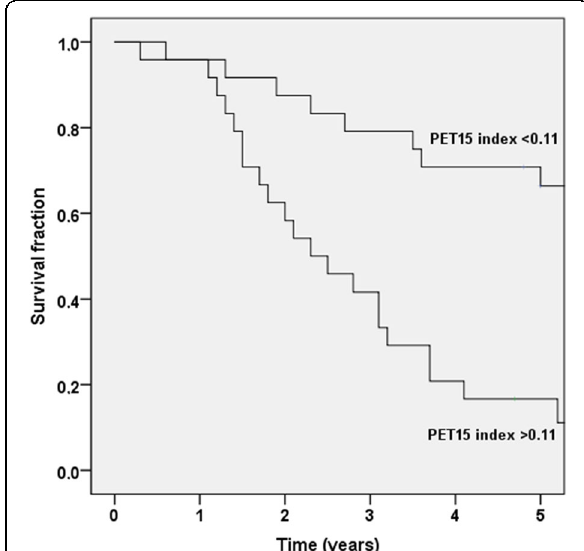
Fig. 6 The Kaplan-Meier survival curves for the two automated PET 15 index groups (<0.11 and